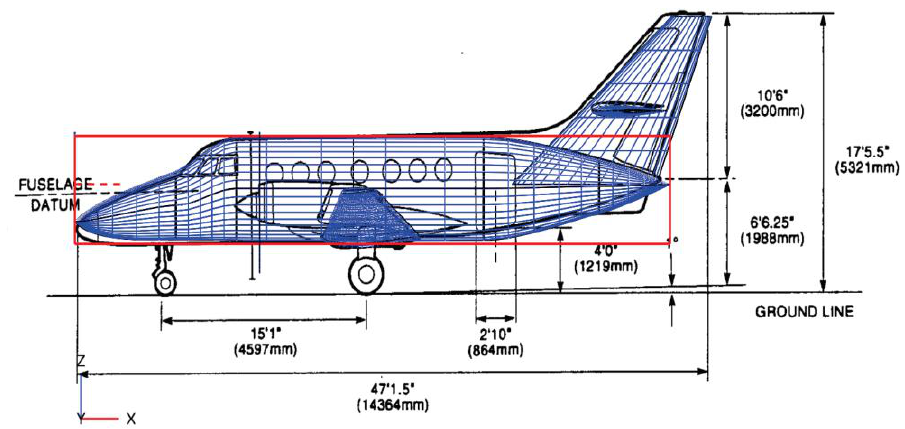
Figure 3. Reference model side view (overlaid on the aircraft maintenance manual [25] view).